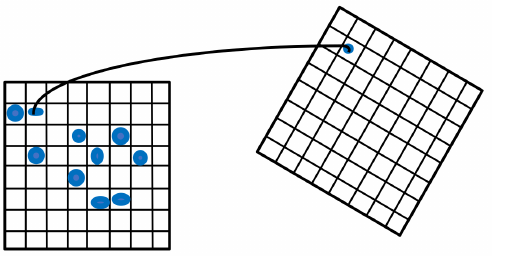
Figure 1. NDT diagram. The blue dots show the various normal distributions. By calculating the mean and covariance in each grid in the reference point cloud